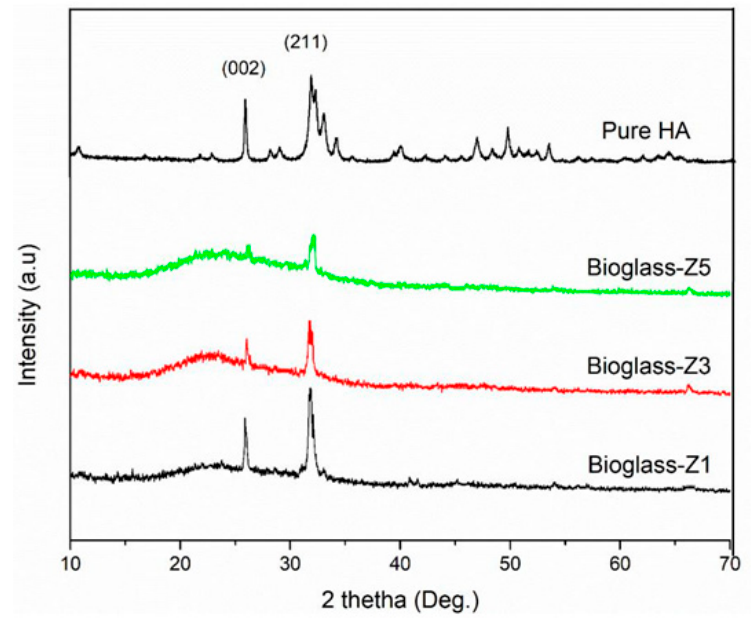
Figure 4. XRD diagrams of bioactive glasses 70SiO 2 –(30-x)CaO–xZnO (mol.%, x = 1, 3,